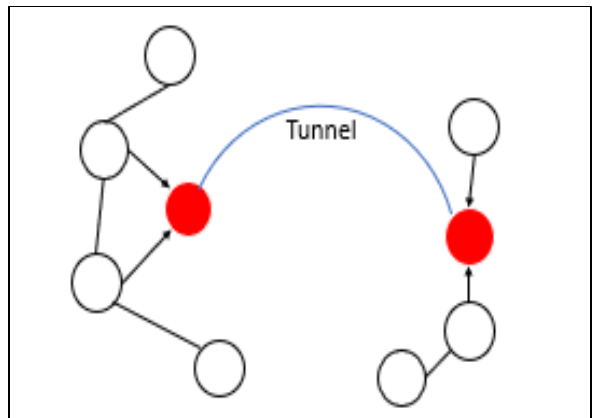
Figure 5. An illustration of the Wormhole attack